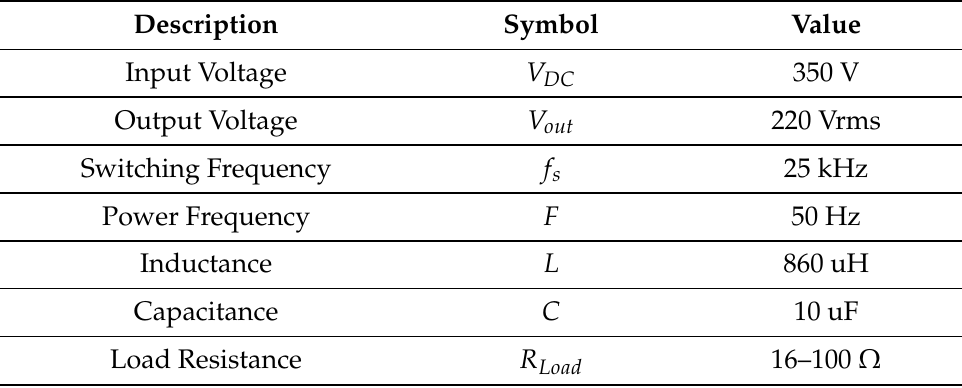
Table 2. Simulated parameters of inverter.